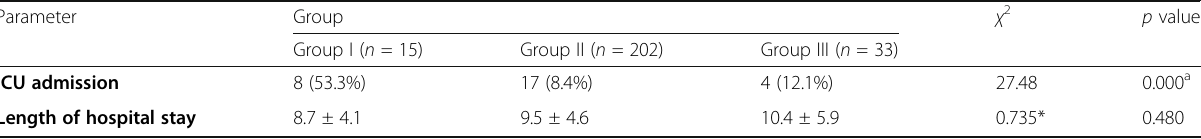
Table 6 ICU admission and length of hospital stay among all studied groups Parameter Group